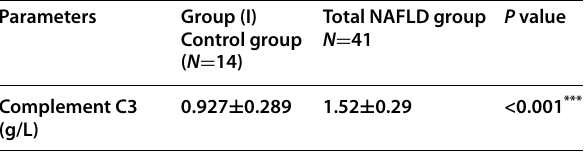
Table 3 correlation between complement C3 and other